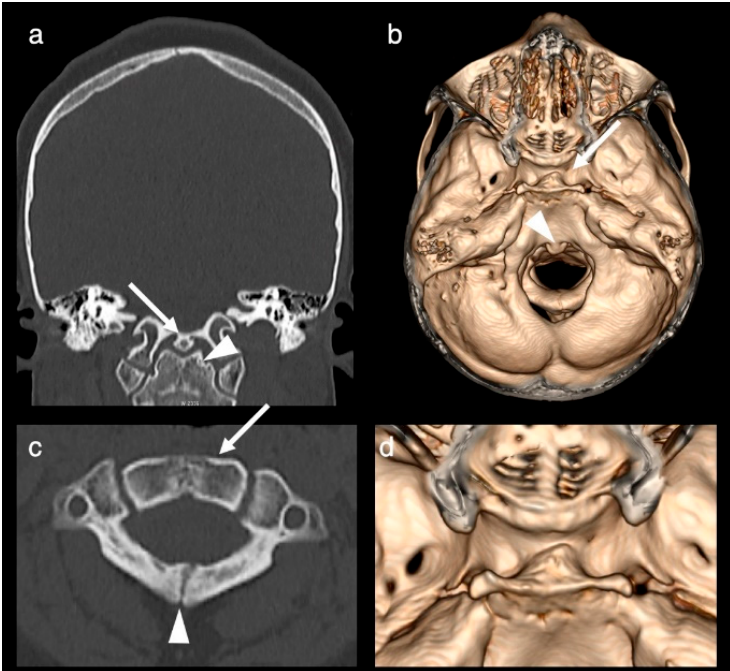
Figure 3. CT obtained at the age of 8 years. Coronal CT-image (bone algorithm; ( a )), axial CT-3D reconstruction ( b ), axial CT-image (bone window, ( c )) and axial CT-3D reconstruction ( d ). Images demonstrate a broadened/duplicated odontoid process (arrowhead in ( a )), a bony fusion of a midline ossicle with the clivus (arrow in ( a ) and arrowhead in ( b )), a broadened base of C2 (arrow in ( c )), a congenital absence of the anterior arch of the atlas ( c ), an incomplete fusion of the posterior synchondrosis (arrowhead in ( c )) and a broad and shallow sella turcica, which is divided into two fossae by a midline osseous ridge (arrowhead in ( b ) and close up in ( d )).